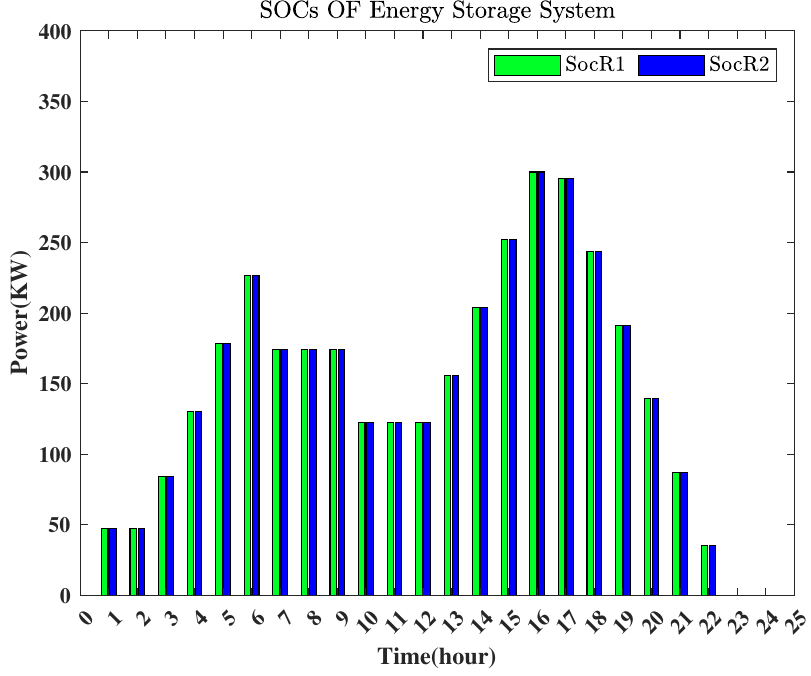
Figure 5. The stored energy level in the electrical energy storage